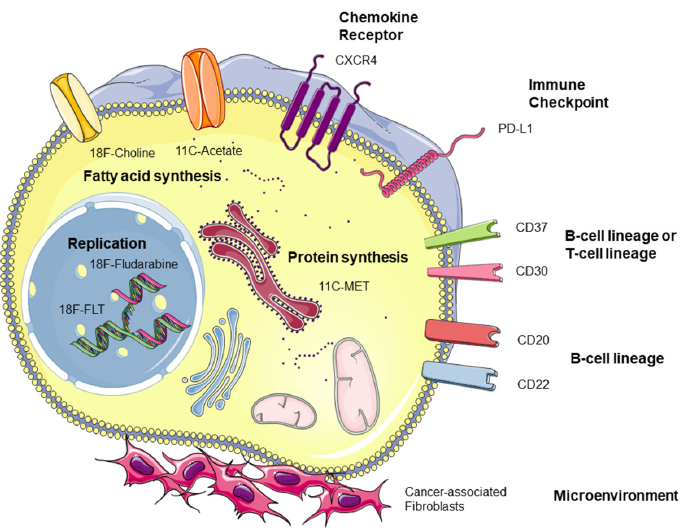
Figure 2. Receptors and metabolic pathways for molecular imaging applications in lymphoma.